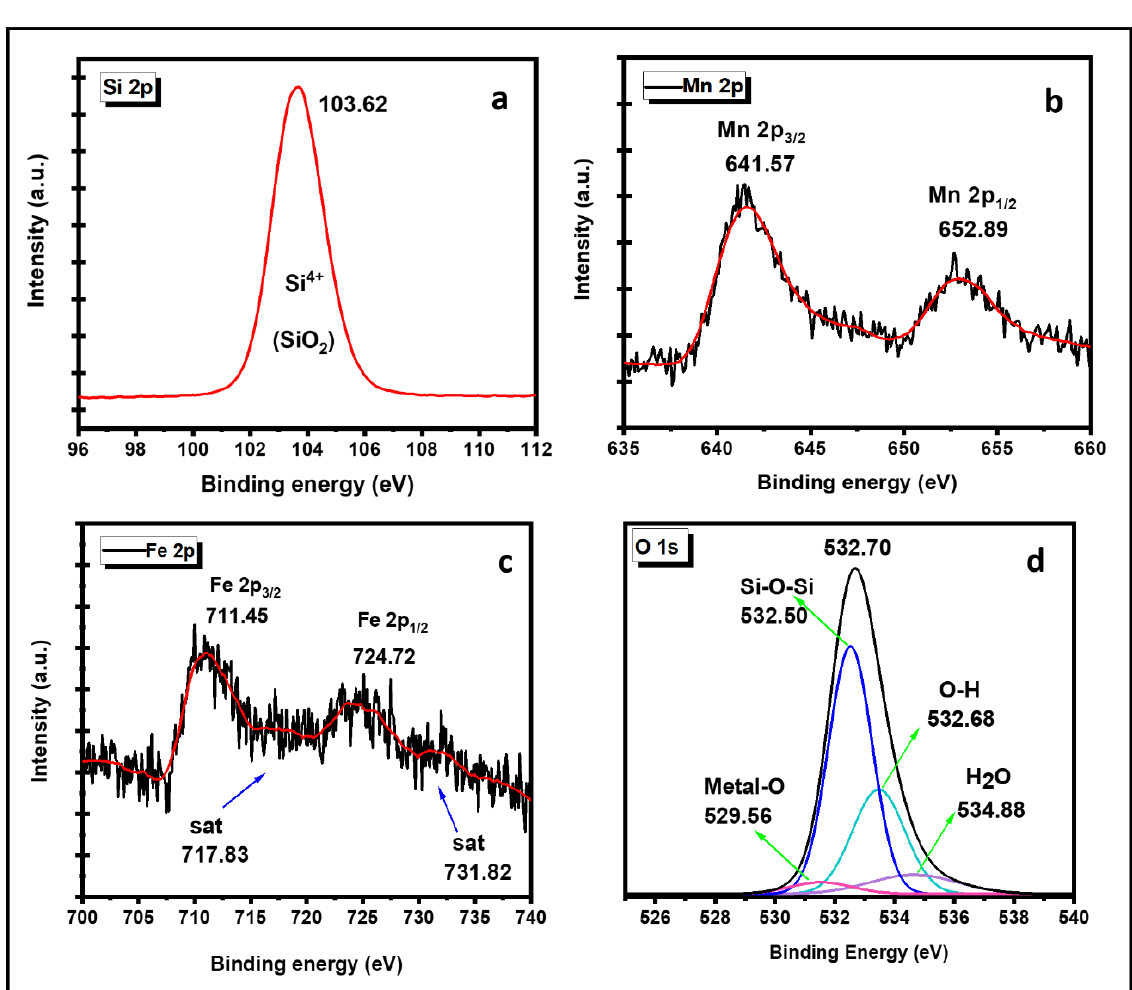
Figure 6. ( a ) HRXPS Si 2p spectrum; ( b ) HRXPS Mn 2p spectrum; ( c ) HRXPS Fe 2p spectrum; ( d ) HRXPS O 1s spectrum Mn 1 Fe 5 @SiO 2